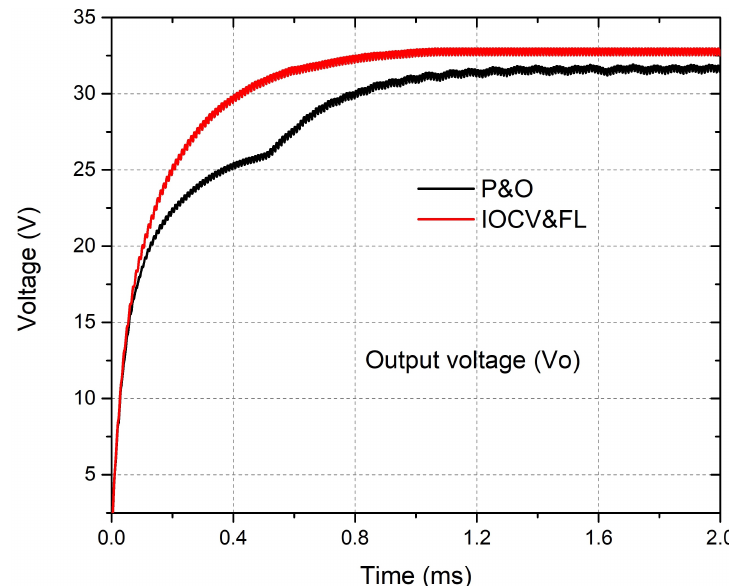
Figure 10. Output voltage plot.